Question: Write a caption explaining this figure to a reader.
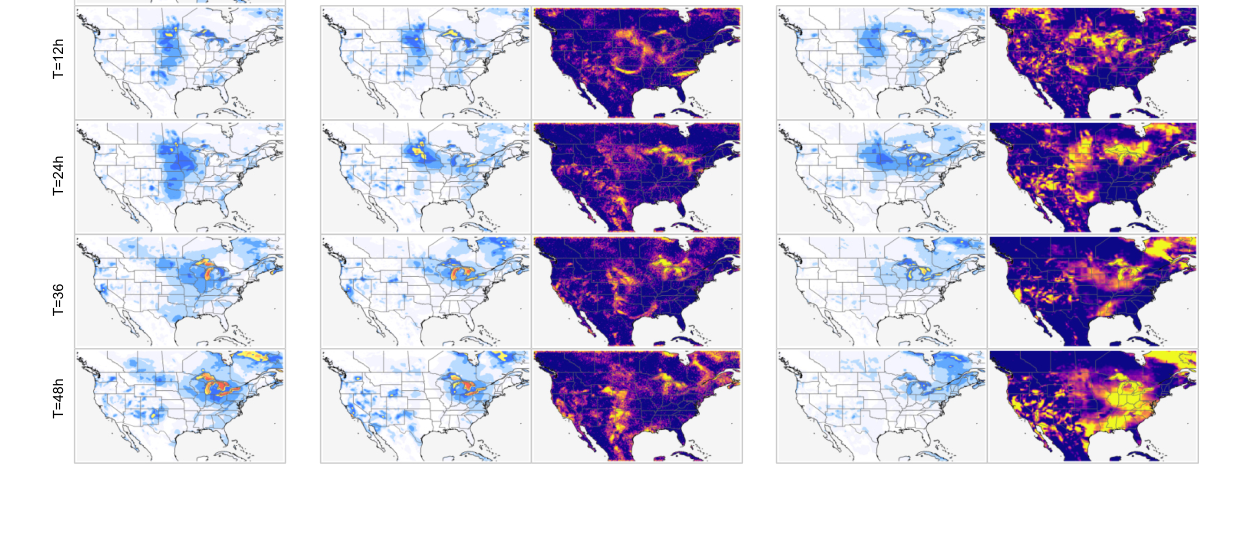
Answer: Additional case studies on ERA5 surface wind prediction. a Case study of the ERA5 wind forecast from 2017-01-02 18:00. The CogDPM successfully prediction the high wind region moving from mideast USA to the Great Lakes. FourCastNet overestimate the moving spatial scale and underestimate its intensity for T=36h and T=48h. The inverse precision field of CogDPM indicate an unpredictable region for mideast USA at T=48h where the prediction neglect. FourCastNet uncertainty focus on the east-south USA at T=48, but is irrelevant with the truth field. Maps produced by the Cartopy package.